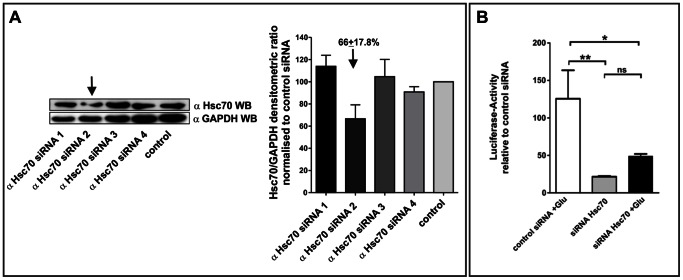
siRNA mediated knock-down of Hsc70 results in significantly reduced NF-κB activity.
A. Screening for functional- and non-functional constructs in mouse astrocytes. Cells were transfected with siRNA expression constructs, cultivated for 48h and processed for western blot analysis using anti-Hsc70 antibody. GAPDH was used as control. The construct inducing the strongest knock-down in astrocytes (arrow, 66% of the control) was used for the transfection of hippocampal neurons. B. Hippocampal neurons were transfected with luciferase reporter plasmids and αHsc70 siRNA or control siRNA processed for NF-κB dependent luciferase activity assay. A knock-down of Hsc70 resulted in significantly reduced NF-κB activity compared to control. Note that neurons transfected with αHsc70 siRNA showed low NF-κB activity even after glutamate stimulus. p value <0.0001.